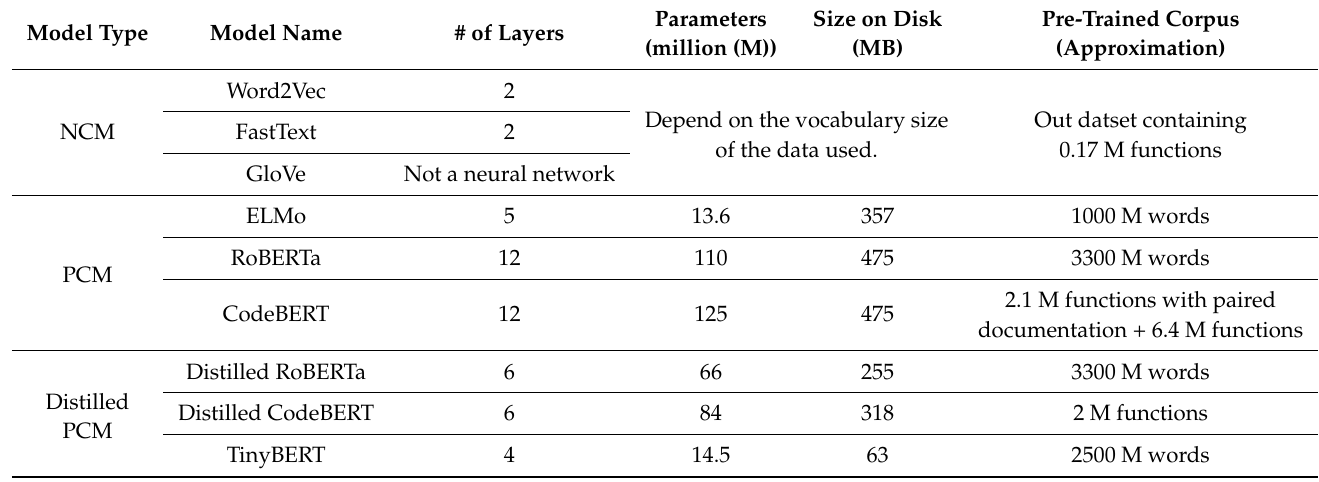
Table 1. The features of the selected nine models, showing their number of layers, parameters, size, and the amount of data used for